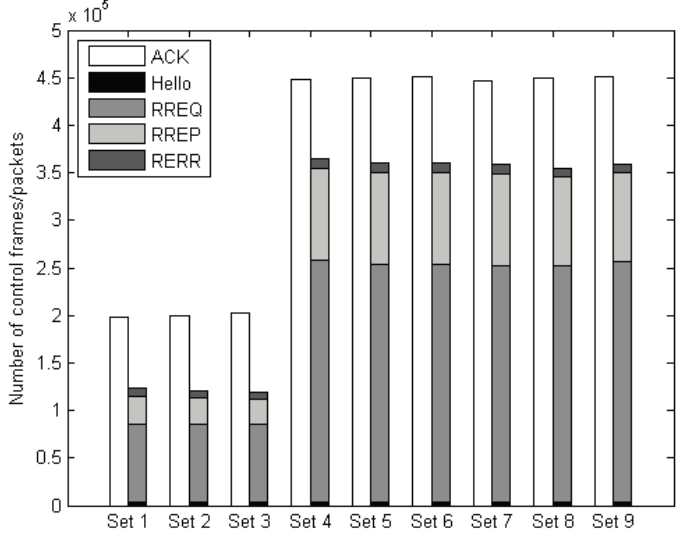
Figure 18. Communication overhead of the protocol